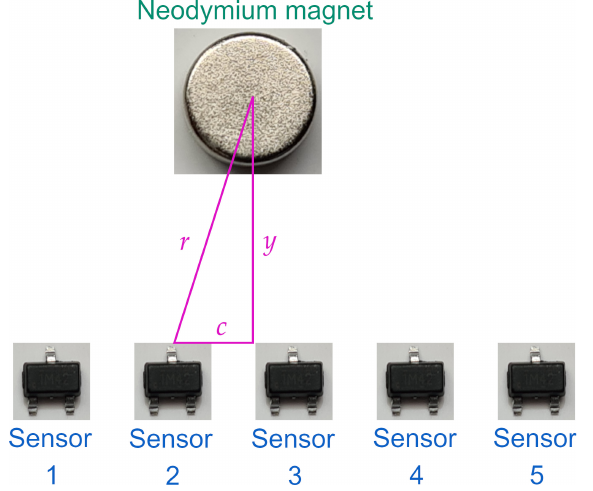
Figure 3. Magnetic sensor array placement. Each sensor is enumerated from S 1 to S 5 ; r is the distance between the magnet M and the considered sensor; y is a fixed distance that exists between the sensors and the linear shaft; and c is the distance along the axis of the linear shaft between the magnet and the sensor.